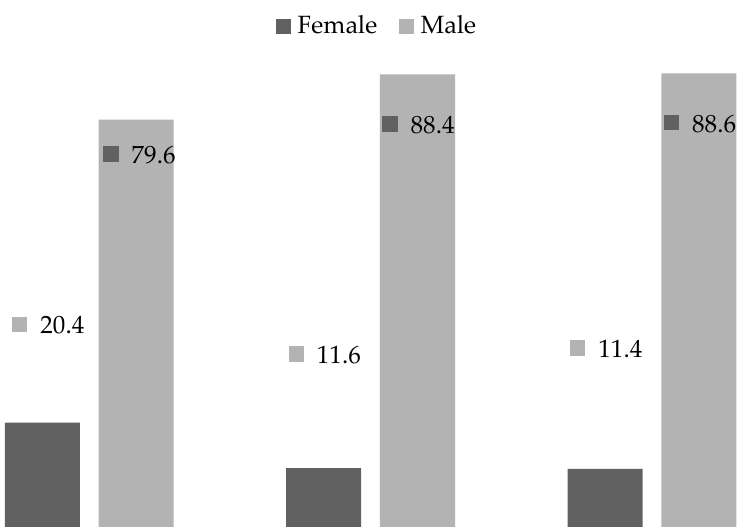
Figure 1. Distribution of the IBEX 35 companies’ management teams by position and gender. Source: SABI database. IBEX companies’ annual reports.